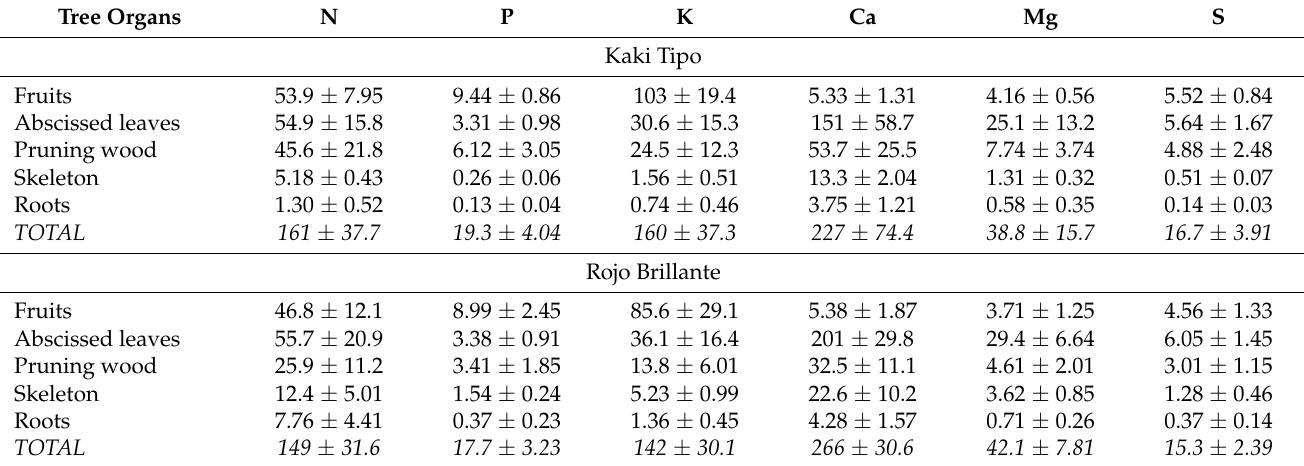
Table 3. Annual macronutrient content (g tree − 1 year − 1 ) in tree organs of mature persimmon of cultivar Kaki Tipo and Rojo Brillante (means ± SD; n = 20 for new growth and 4 for perennial organs).